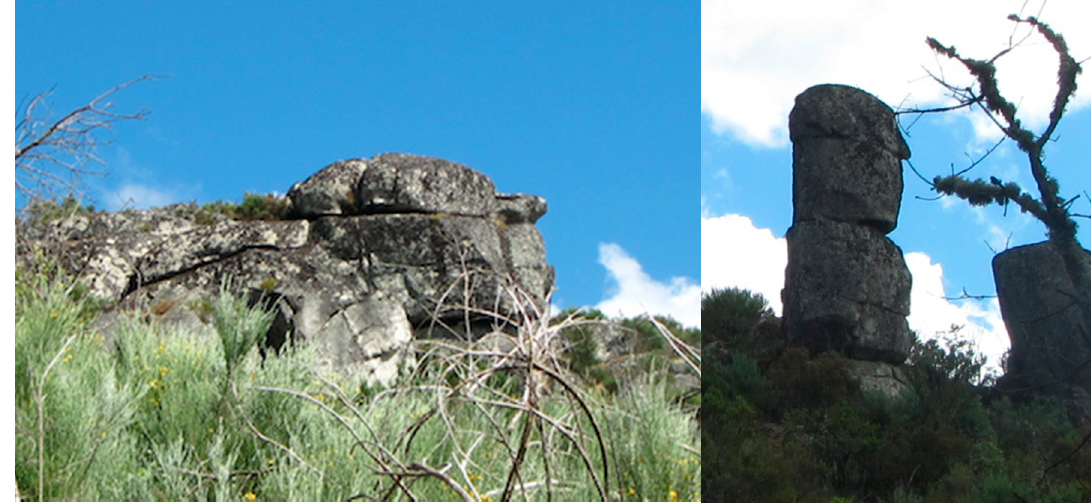
Figure 6. Zoomorphic block (turtle) and ( left ) and anthropomorphic block (man’s head) ( right ).